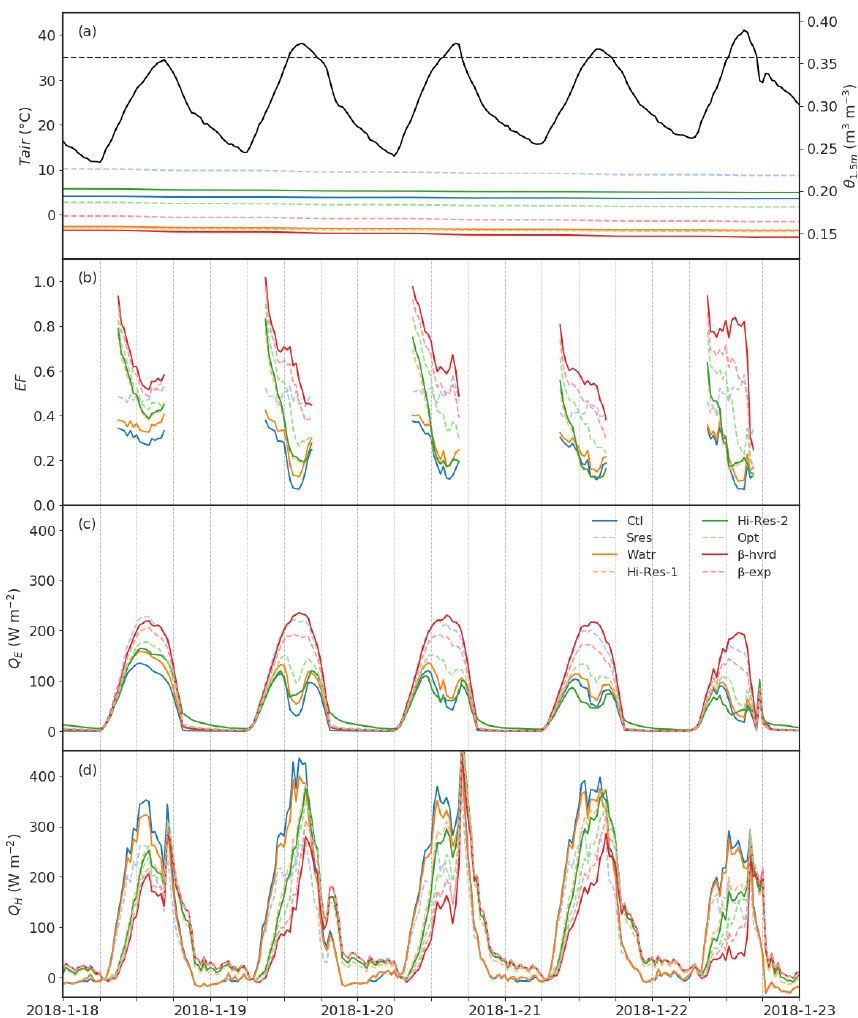
Figure 10. Simulations during an observed heatwave with relatively low soil moisture (19–22 January 2018). (a) Air temperature ( T air ; in black) and soil moisture within root zone over the top 1.5m ( θ 1 . 5m ). The black dashed line shows the 35 ◦ C threshold. (b) Evaporative fraction (EF; calculated for daytime conditions), (c) latent heat ( Q E ) and (d) sensible heat ( Q H ). The vertical dash lines in panels (b–d) are at a 6h interval to assist plot reading. One day before the heatwave is also